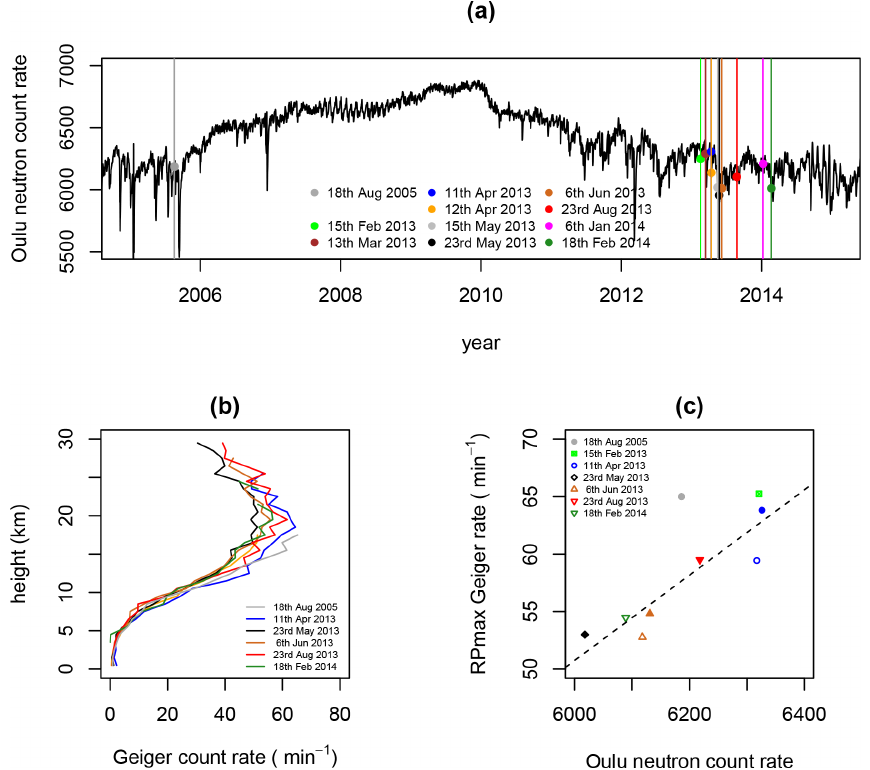
Figure 11. Comparison of Geigersonde profiles with the surface neutron monitor at Oulu. (a) Oulu neutron data time series, with Geigersonde flights from Reading marked. (b) Count rate profiles from selected Geigersonde soundings, showing the increase from the surface to the Regener–Pfotzer (RP) maximum at around 20km altitude. (c) Comparison of the RP maximum Geiger count rate (RPmax) with the Oulu neutron monitor count rate at the same time (solid symbols indicate ascent data, and hollow symbols descent). (Adapted from Harrison et al.,